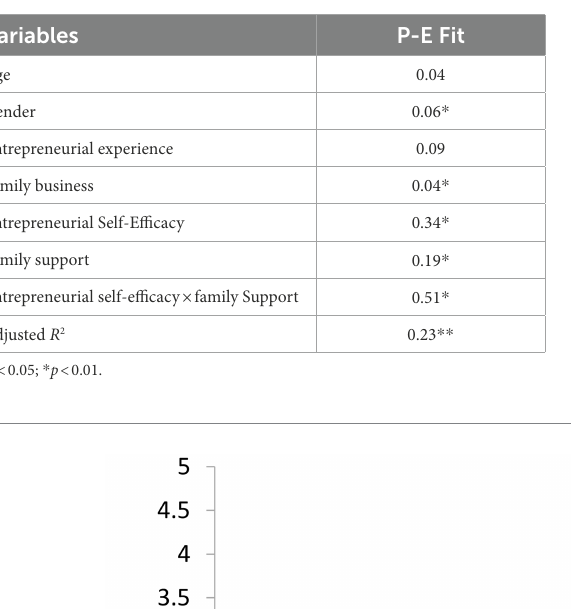
TABLE 4 Moderation results.